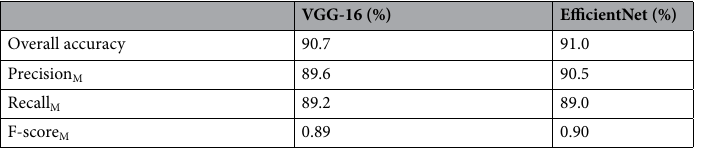
Table 1. Comparison of two trained CNN models with four performance metrics (“Materials and methods”). VGG-16 and EfficientNet reached the best overall accuracy at 65th and 161st epoch,